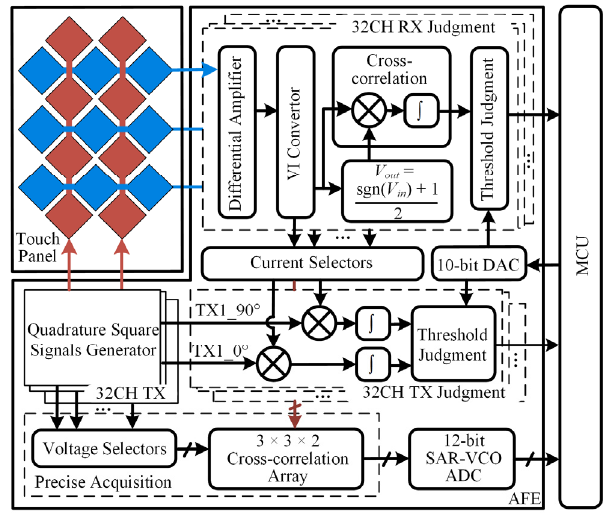
Figure 2. The architecture of the proposed low-computing-complexity AFE circuit based on cross- correlation operation.